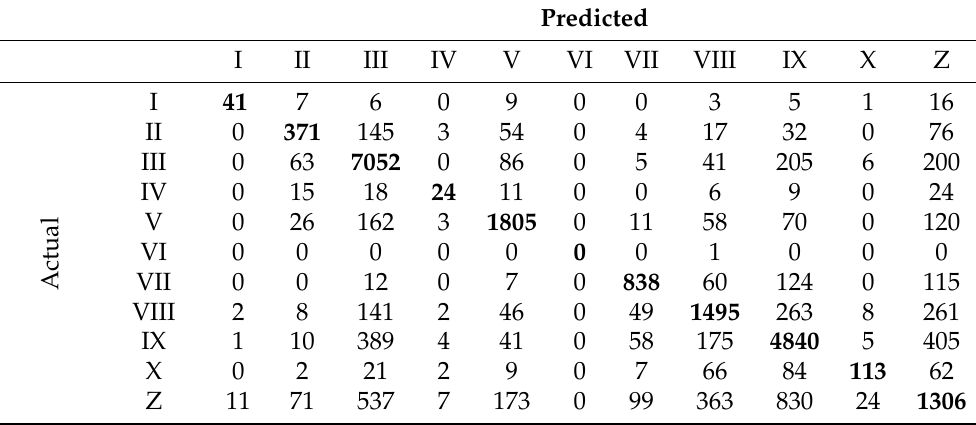
Table 5. Economic activity prediction confusion matrix using SVM (top-1).